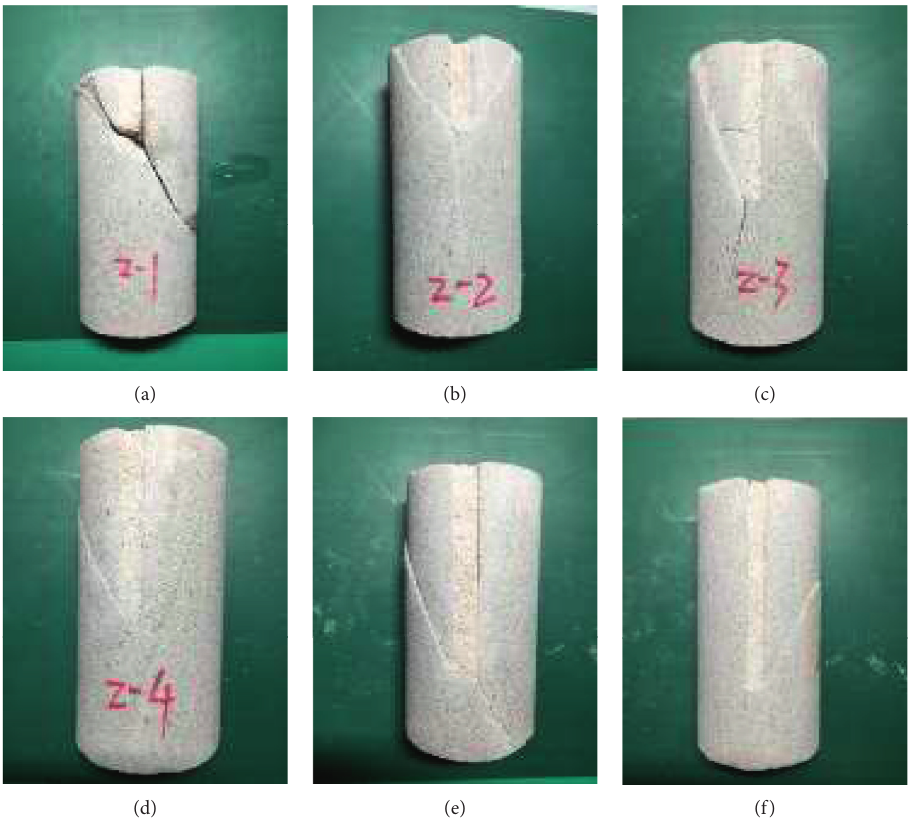
Figure 3: Failure of the cracked rock under seepage stress. (a) 2-1. (b) 2-2. (c) 2-3. (d) 2-4. (e) 2-5. (f) 2-6.